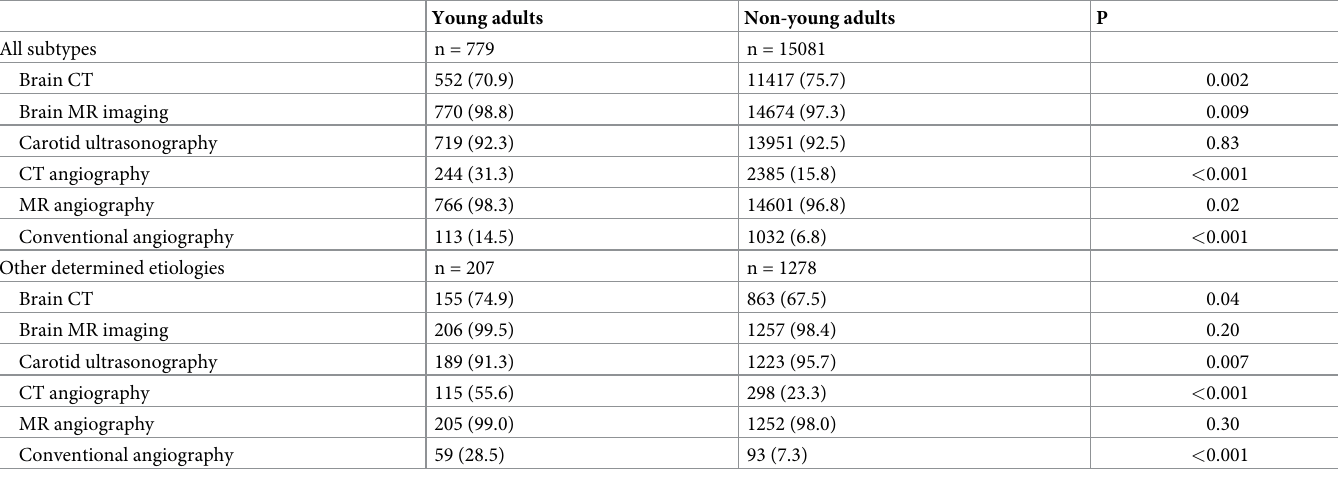
Table 4. Vascular assessments for stroke etiology in young adults and non-young